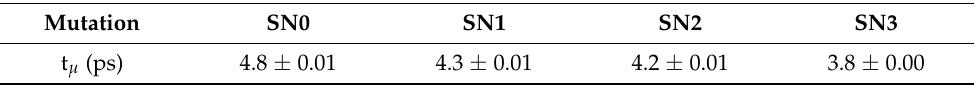
Table 5. Fitting results for C µ ( t ) in mutations. The uncertainty is mean square deviation between the raw data and the best fitting